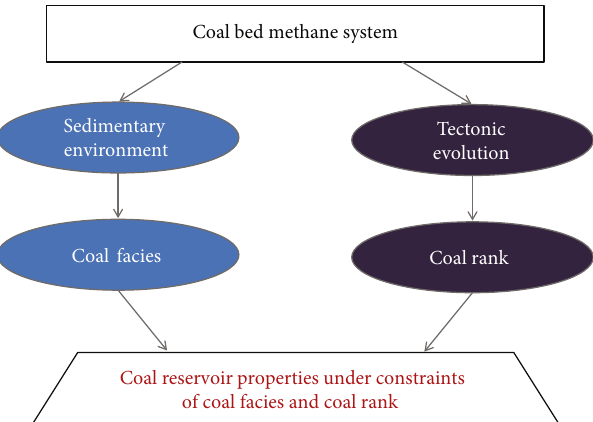
Figure 12: Relationship among sedimentary environment, tectonic evolution, coal facies, coal rank, and reservoir